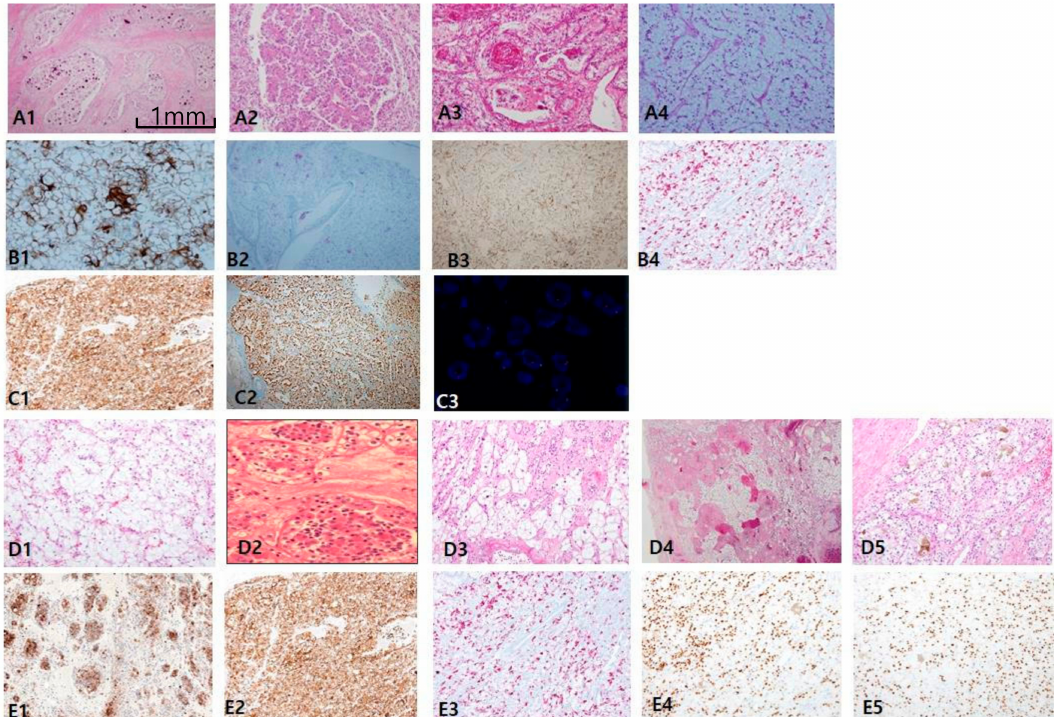
Figure 5. Microphthalmos translocation family RCC (MiT RCC). ( A1 – A4 ) In MiT RCC,